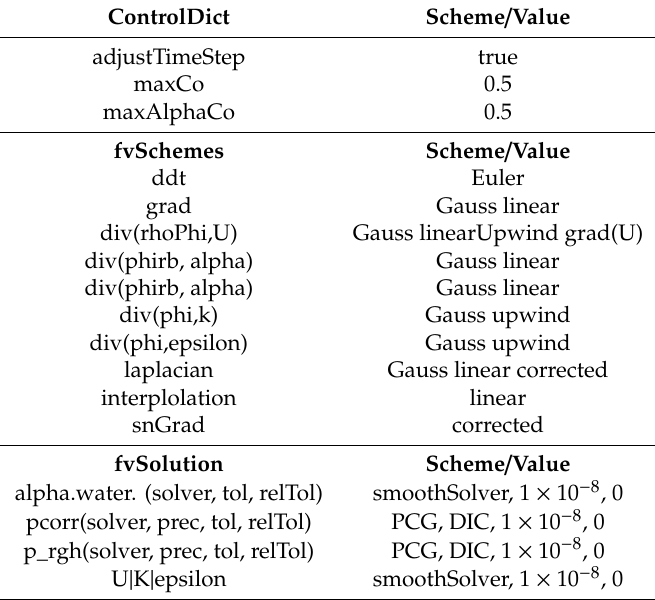
Table 1. interFoam parameters.